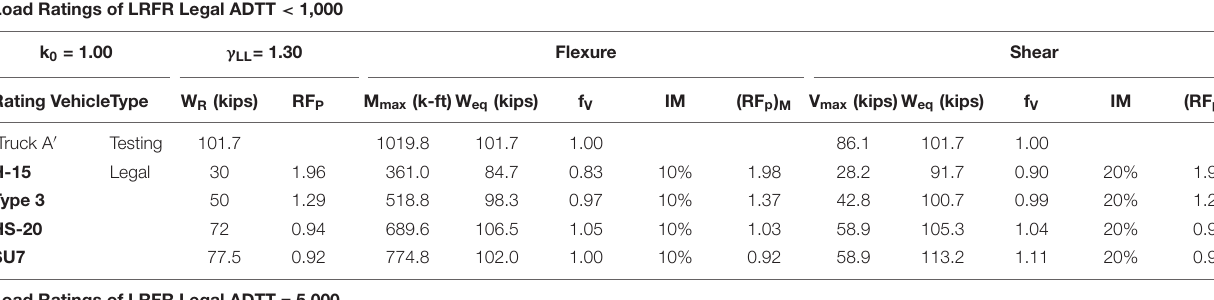
TABLE 5 | Lower-bound bridge load ratings derived from proof test results. Load Ratings of LRFR Legal ADTT < 1,000 k 0 = 1.00